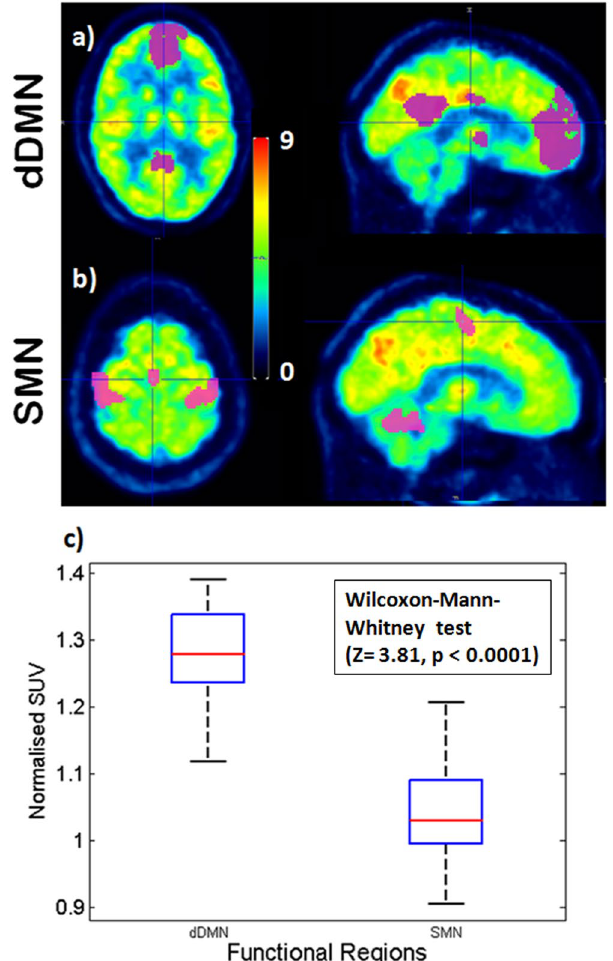
Figure 7. FDG SUV in the dDMN and SMN. Resting state FDG PET SUV image of an exemplary subject with ( a ) dDMN and ( b ) SMN masks (upper two rows). ( c ) The box plot shows the normalised SUV in dDMN mask and SMN mask for 11 subjects.